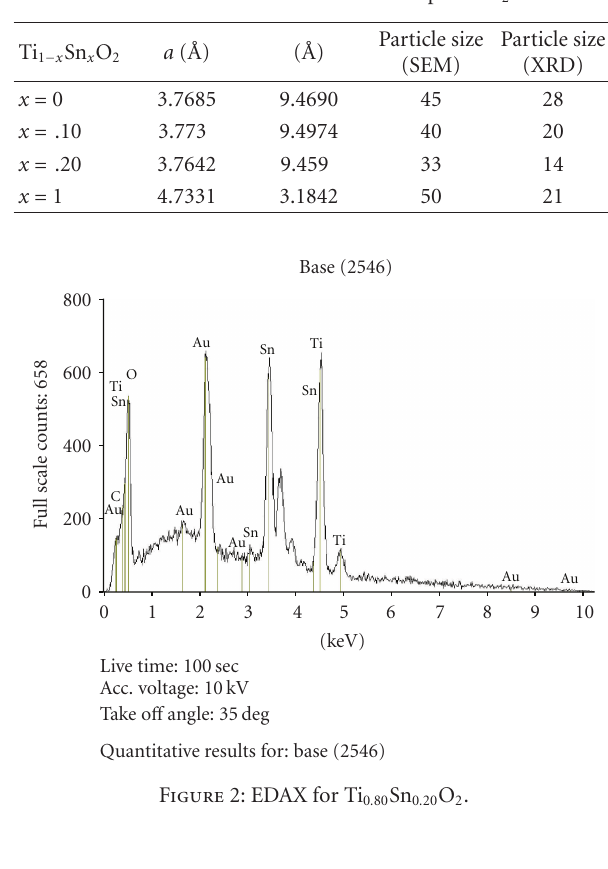
Table 1: Lattice constants of Sn-doped TiO 2 .